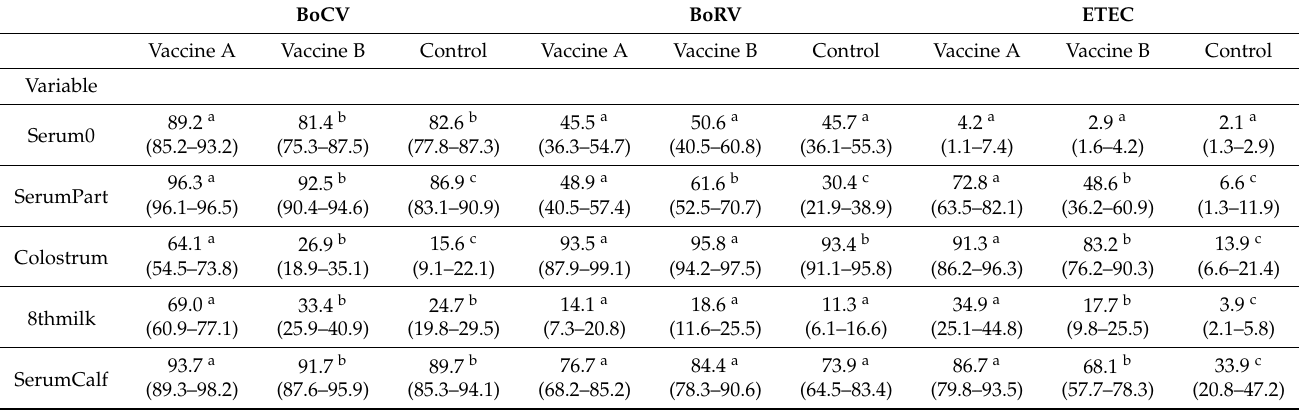
Table 1. Antibody titre against BoRV, BoCV and ETEC K99 in serum, colostrum and 8th milk samples (values expressed as percentage of inhibition ELISA) in the dams of the different groups (Vaccine A, Vaccine B and Control). Additionally included are their calf’s serum values. Data are presented as median and confidence intervals (95%).